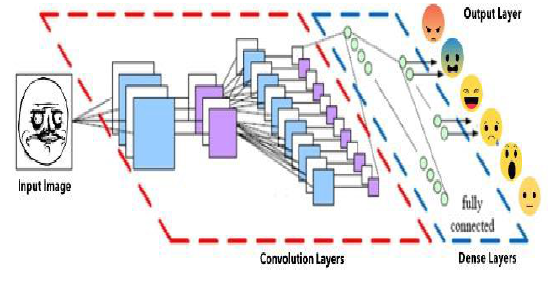
Fig. 3. Convolution Neural Network Layers